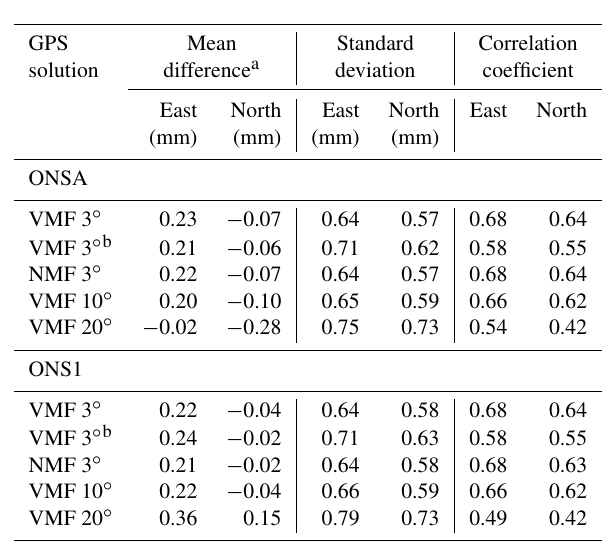
Table 9. Assessment of the different GPS solutions for the wet gra- dients from the two GPS stations ONSA and ONS1 relative to the WVR data.